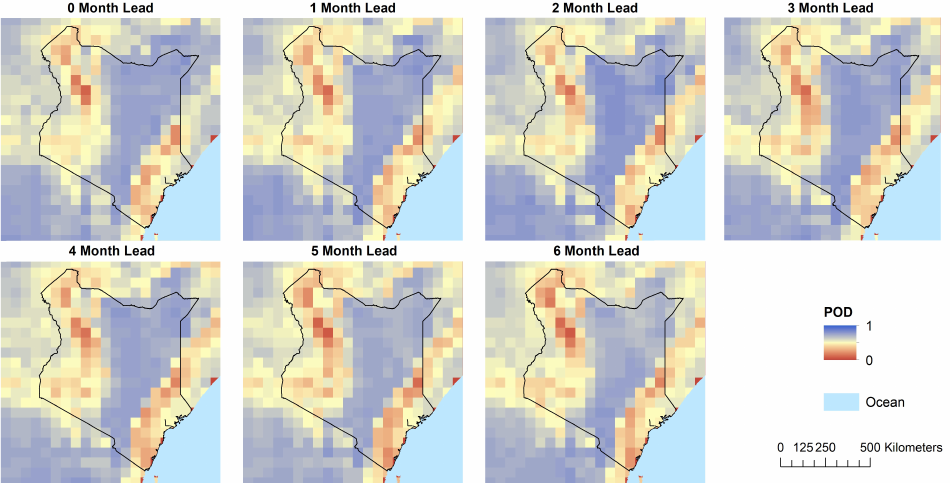
Figure 4. Probability of detection for dry anomaly